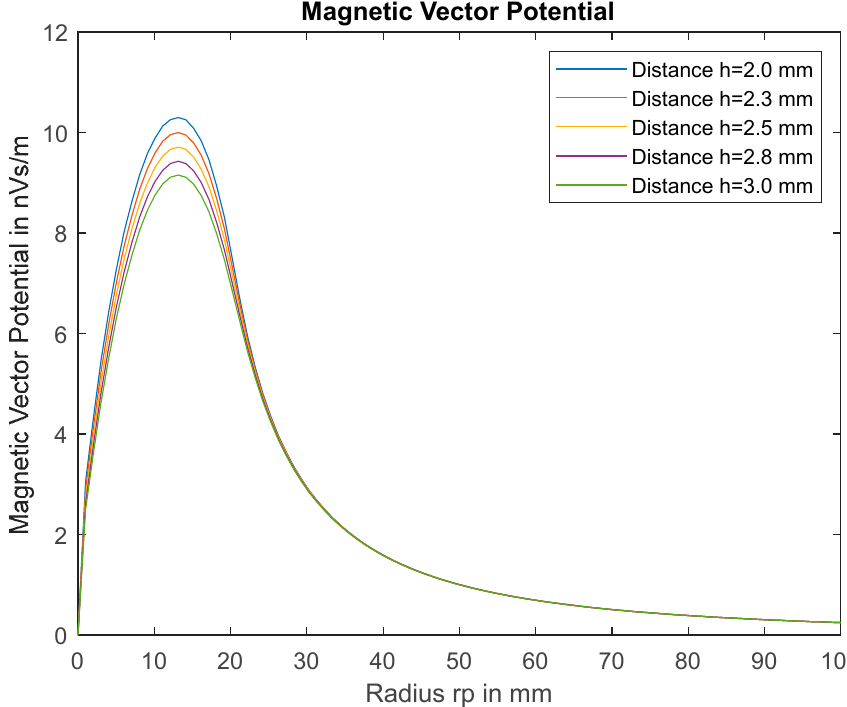
Figure 3. Magnetic Vector Potential for different distances.